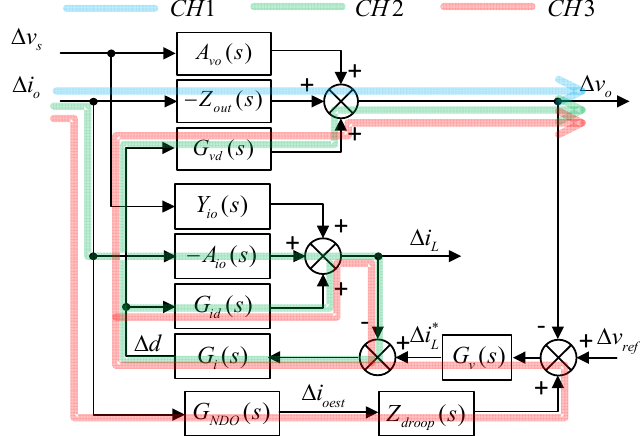
Figure 10. Small-signal model diagram of the dc/dc converter.